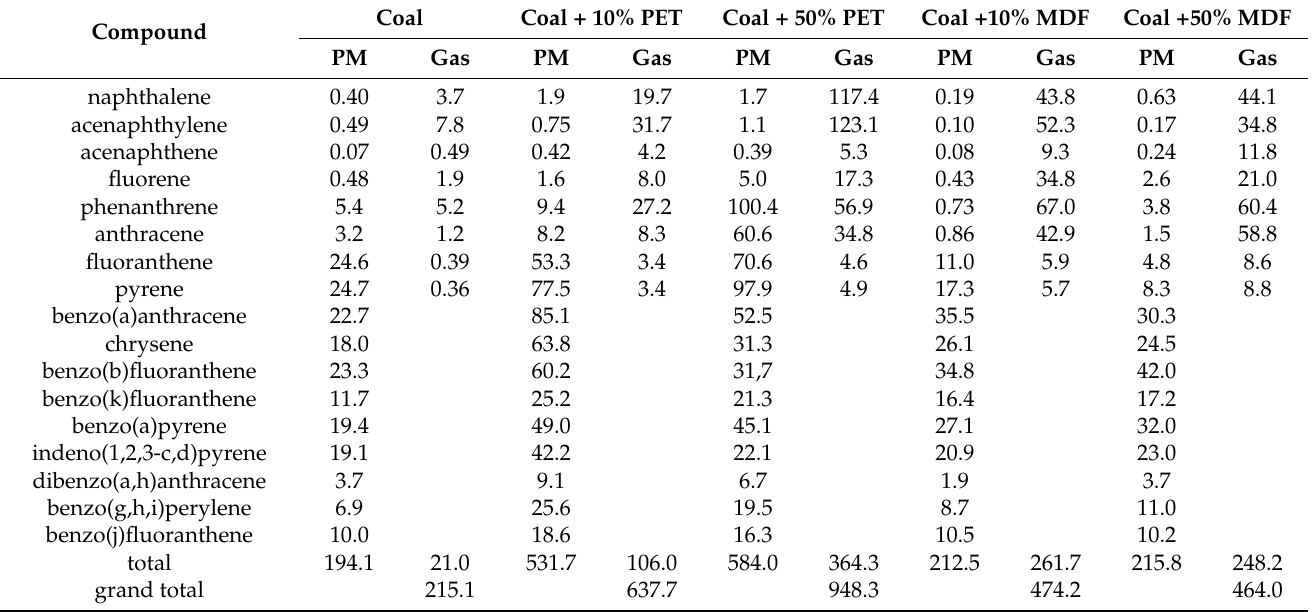
Table 7. PAHs emission factors